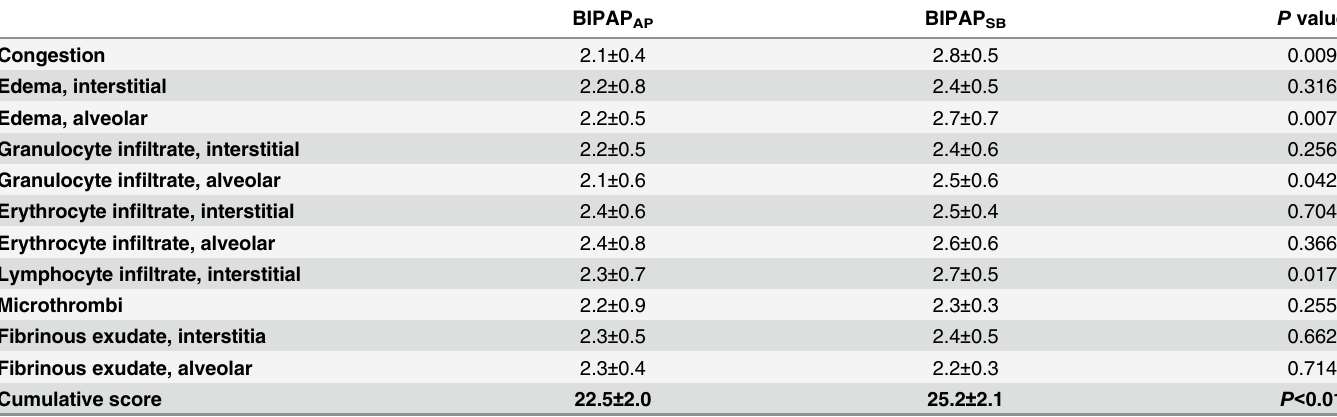
Table 2. Histological subscores in experimental